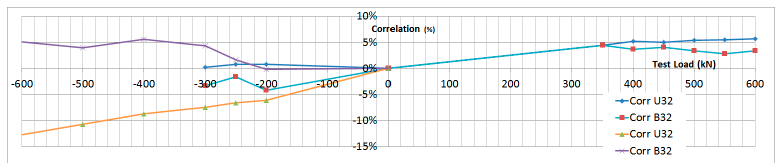
Figure 20. Failure Load Test Data Correlation.